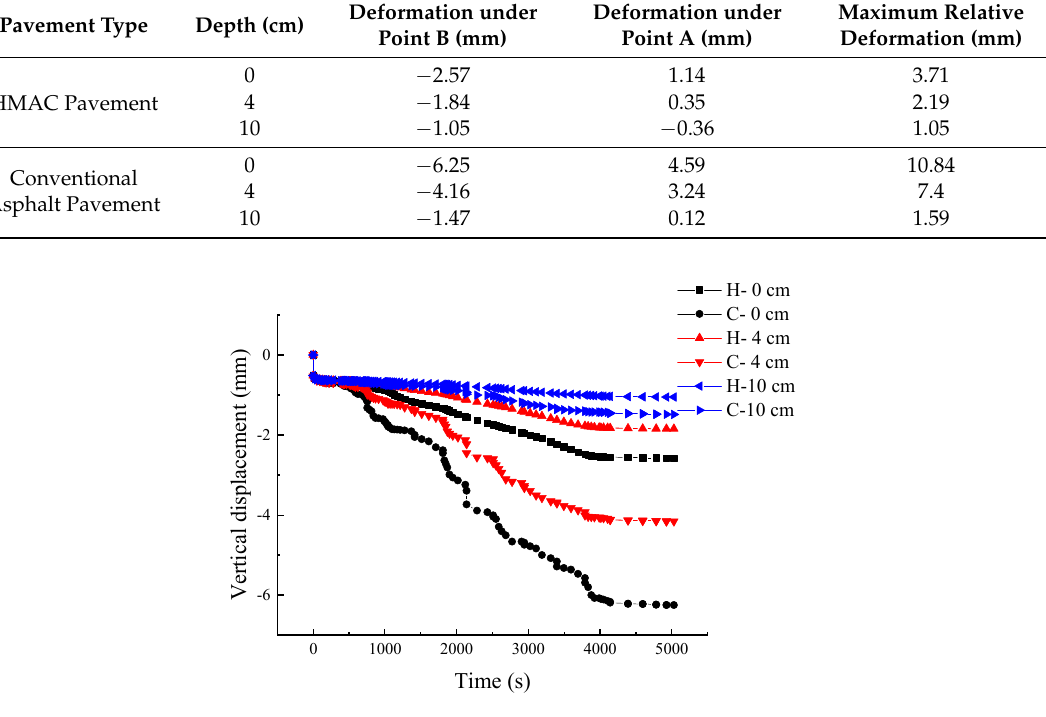
Figure 12. Comparison of vertical deformation at different depths underneath the center of the leftmost wheel.